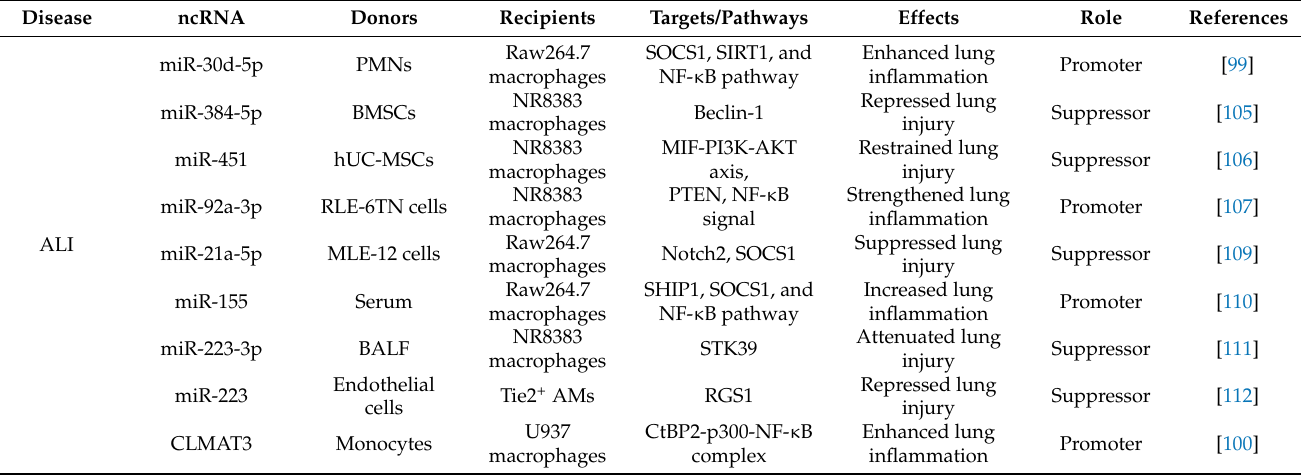
Table 2. Summary of effects of exosomal ncRNAs on inflammatory lung diseases.